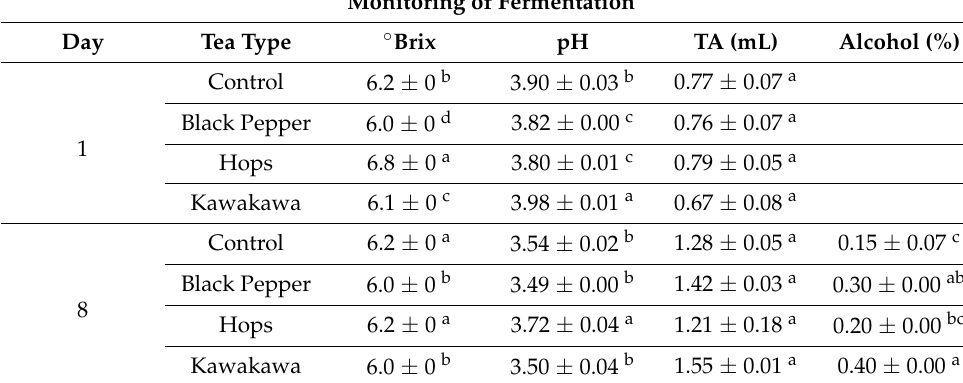
Table 1. Parameters used to monitor the fermentation performance of different Kombucha samples. TA stands for titratable acidity. Different superscript letters refer to statistically significant samples ( α